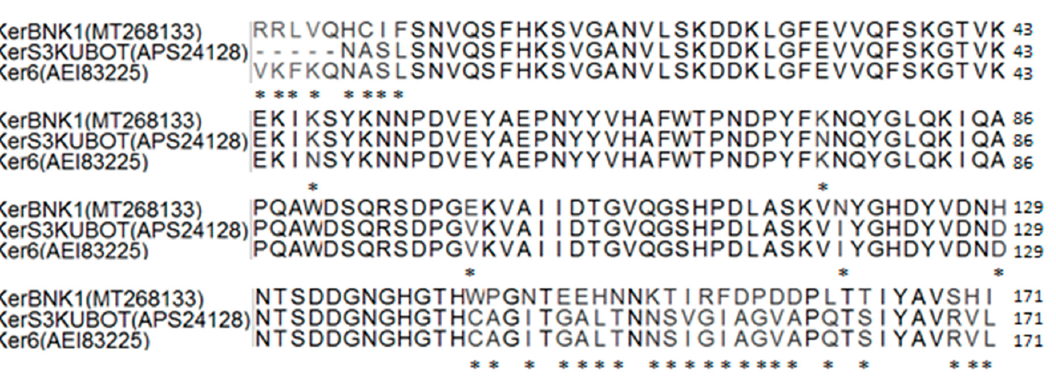
Figure 8. Amino acid sequence alignment of KerBNK1 with the keratinases of Bacillus thuringiensis S3KUBOT (KerS3KUBOT) and Bacillus cereus Wu6 (Ker6). *indicates variations in the aligned enzyme sequence residues.